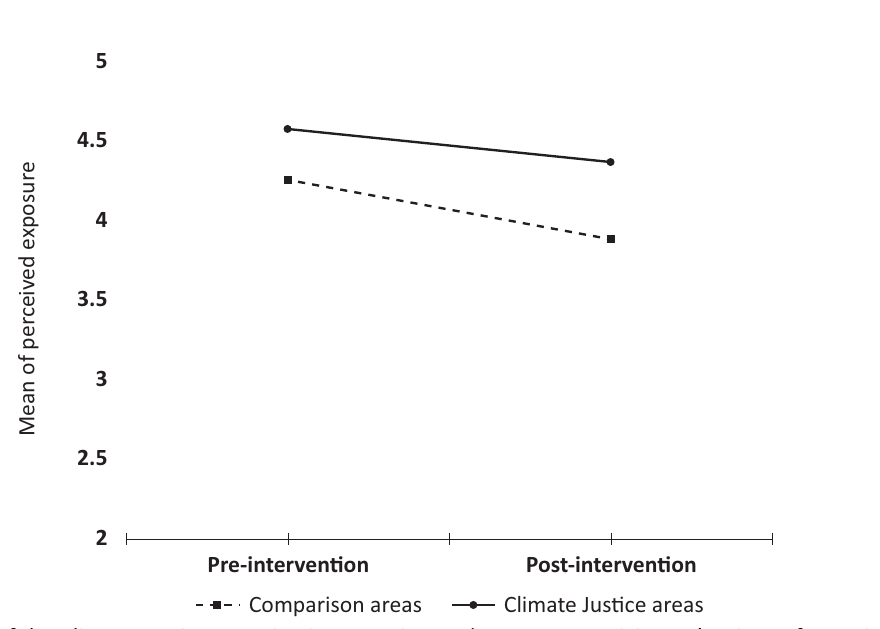
Figure 3. The effects of the Climate Justice mapping intervention and group on participants’ ratings of perceived exposure to future extreme events.